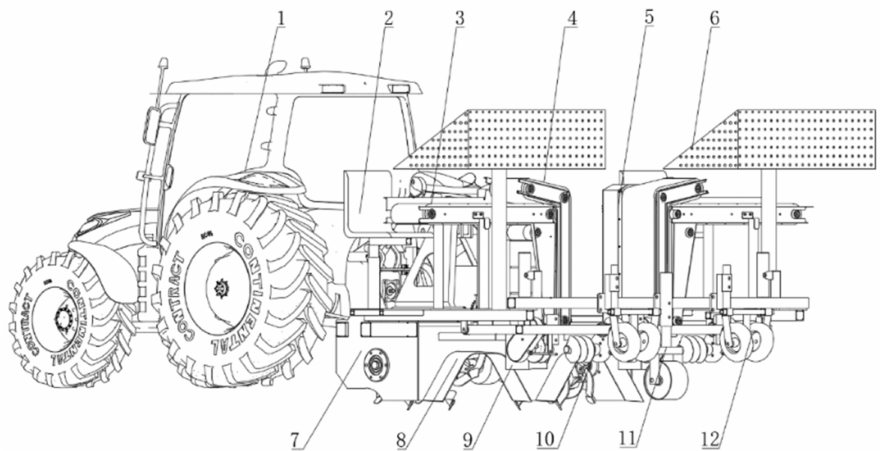
Figure 3. Schematic diagram of horizontal transplanter for bare sweet potato seedlings: 1. Tractor; 2. Seat; 3. Lower seedling transport belt; 4. Upper seedling protection belt; 5. Transmission box; 6. Seedling tray; 7. Rotary tiller; 8. Ridge body forming plate; 9. Ditch opener; 10. Screw mechanism; 11. Support Wheel; 12. Suppression